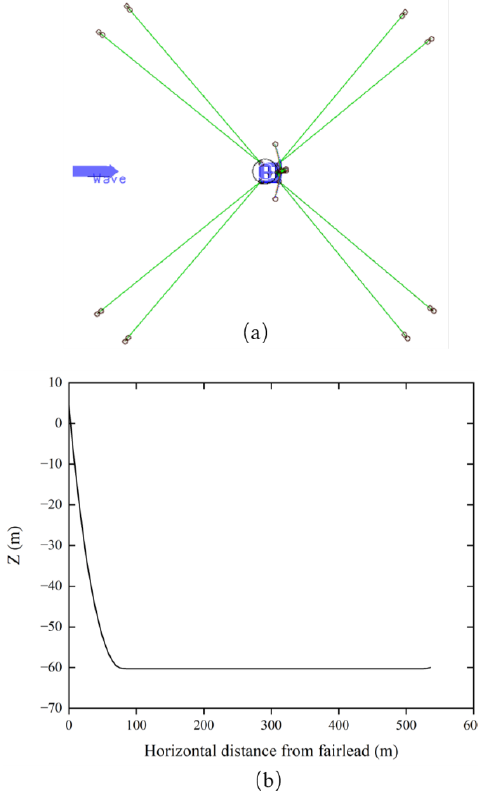
Figure 6. Illustration of the barge platform mooring system. ( a ) Layout of the mooring lines. ( b )